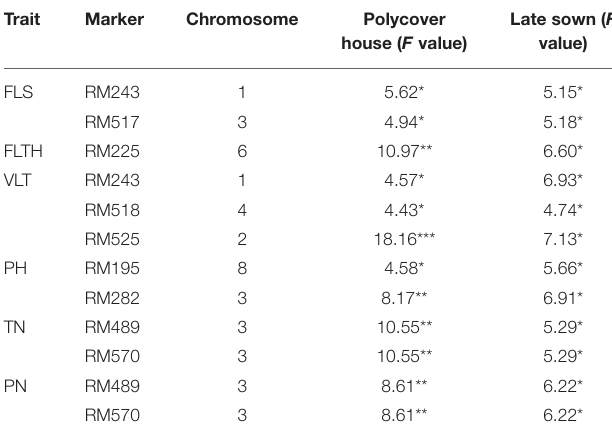
TABLE 3 | Marker trait associations observed only under heat stress conditions in both seasons (under polycover house during wet season 2012 and late sown conditions during dry season